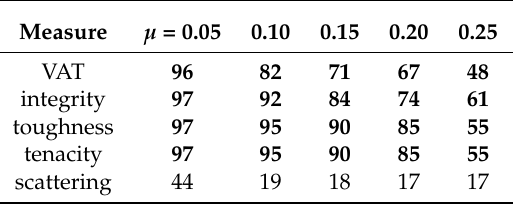
Table 3. Percent Accuracy for NBR–Clustering on LFR Networks of 1024 Nodes. Bold text indicates one-step